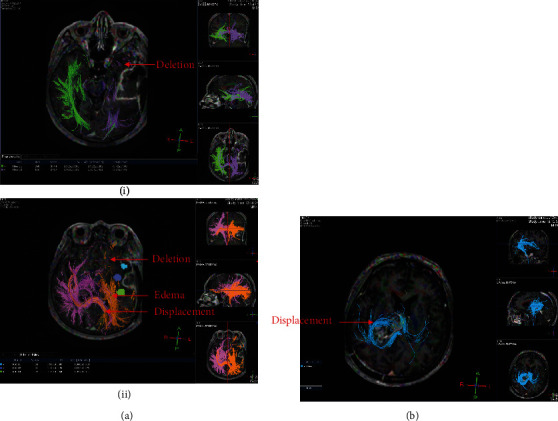
DTI images of the postoperative HGG patient before radiotherapy. (i). DTI images for a 59-year-old male patient who had left temporal lobe glioma (WHO Grade III). Fiber tract disruption and absence outside the surgical cavity. (ii). DTI images for a 64-year-old female patient who had right thalamic glioma (WHO Grade III). The fiber tract was continuous and complete, considering that tumor invasion is not obvious.